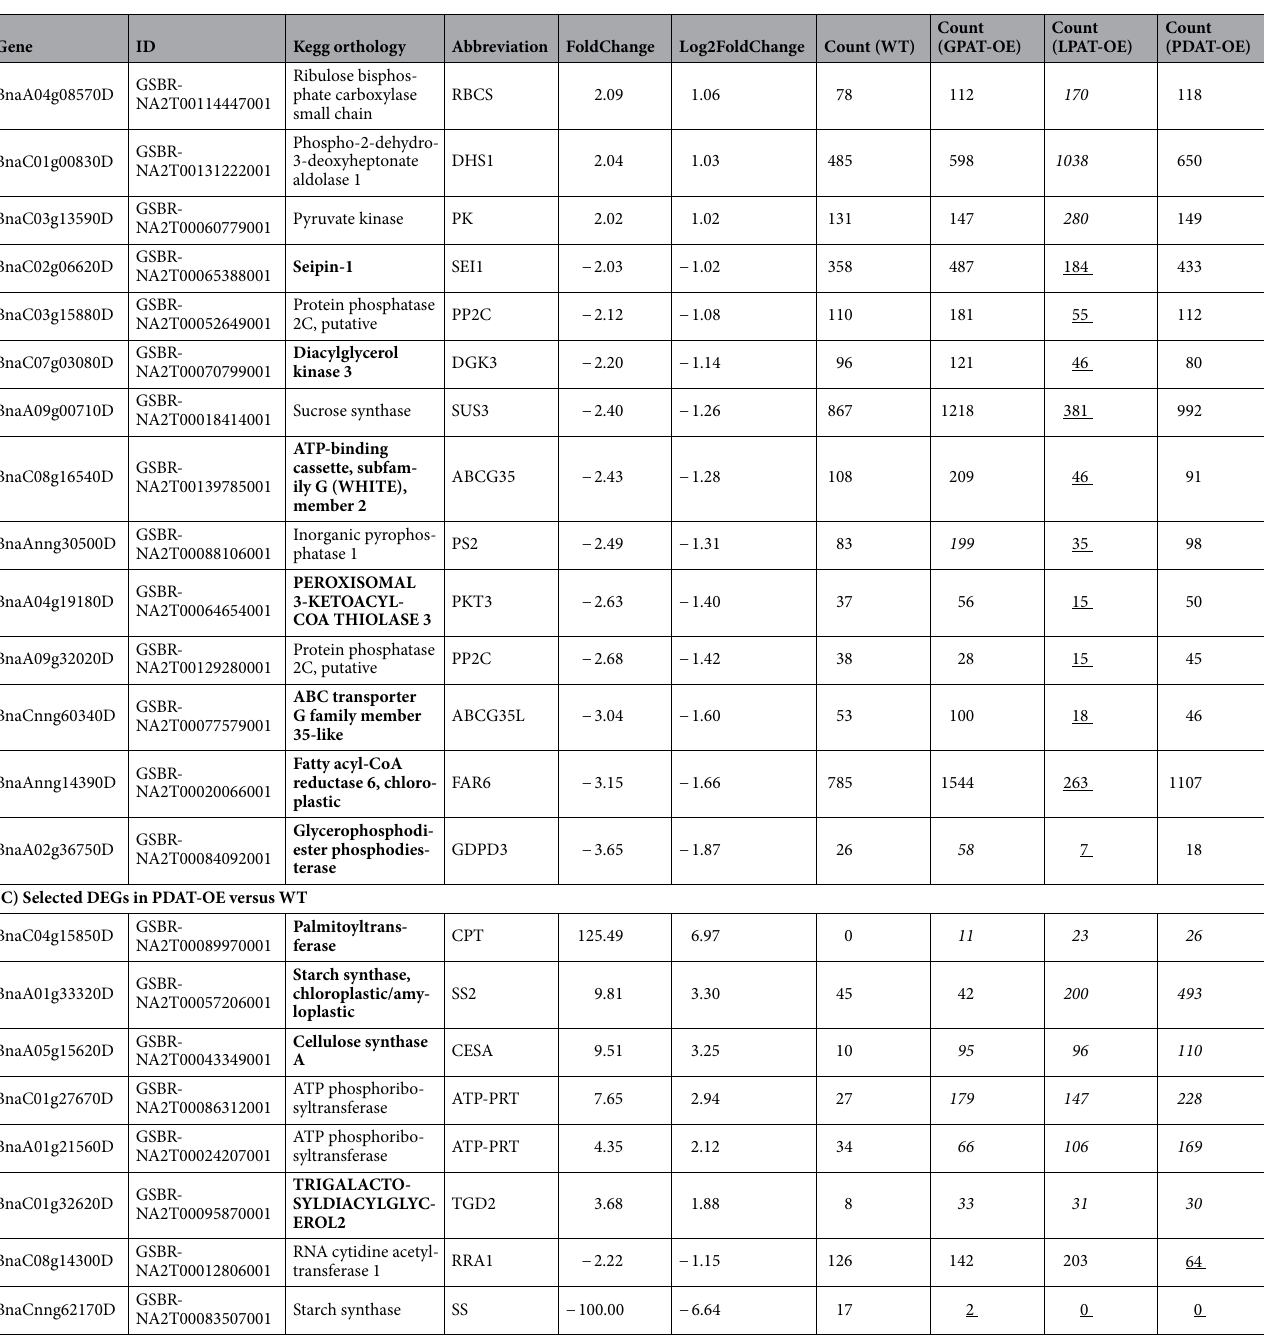
Table 1. Expression values (normalised counts) of selected DEGs associated with acyl-lipid metabolism and related enzymatic functions in GPAT-OE (A), LPAT-OE (B) and PDAT-OE (C) lines compared to WT. Values highlighted in italics and underline indicate significant up-regulation and down-regulation respectively. Bold indicates genes directly related to acyl-lipid